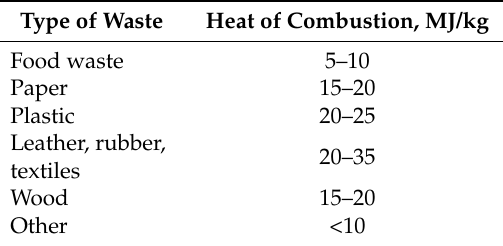
Table 6. Heat of combustion of typical MSW